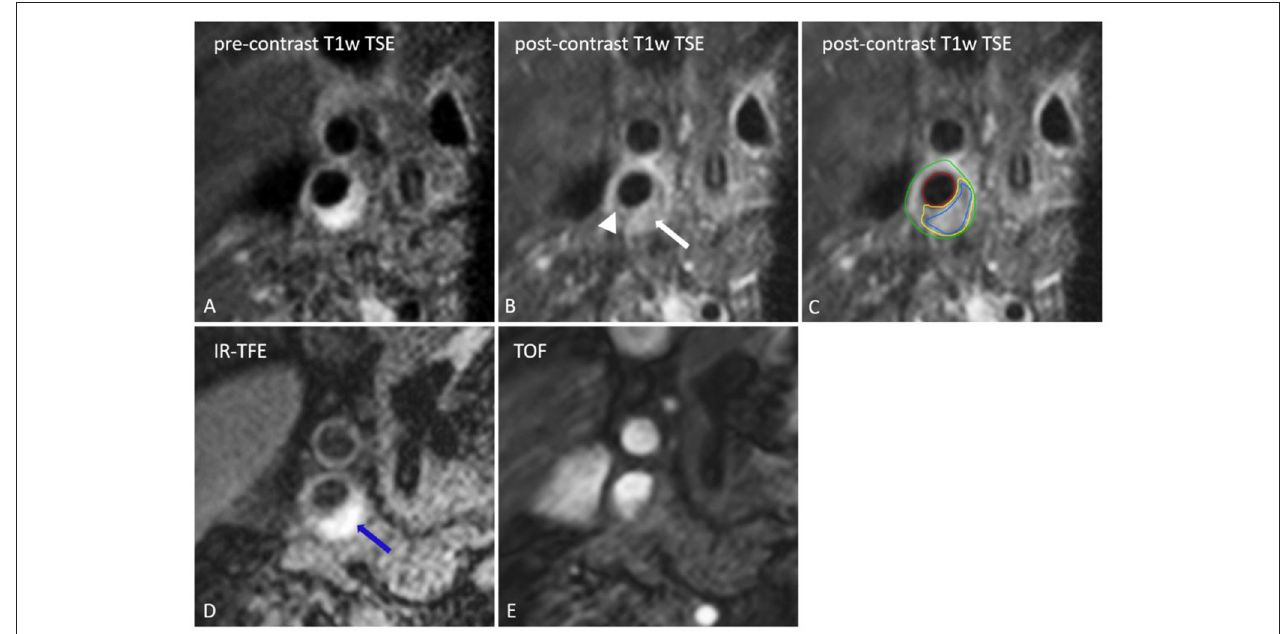
FIGURE 1 | Transversal MR images of the right internal carotid artery. The black blood pre-contrast image (A) is used to draw the contours of the lumen and outer vessel wall. The lipid-rich necrotic core shows no contrast-enhancement on the post-contrast black-blood T1w quadruple inversion recovery (QIR) turbo spin echo (TSE) image (B) and includes the entire area of hemorrhage (IPH) [IPH: blue, lipid-rich necrotic core: yellow, lumen: red, outer vessel wall: green on (C) ]. IPH [blue arrow on (D) ] appears as a bright signal on the inversion recovery turbo field echo images (IR-TFE; D ). A thin or ruptured fibrous cap (TRFC) can be identified by the interruption of juxtaluminal signal enhancement on the post-contrast T1w image (arrow head). With a contra-indication for contrast injection the T2w image or time of flight (TOF) image (E) can be used for TRFC